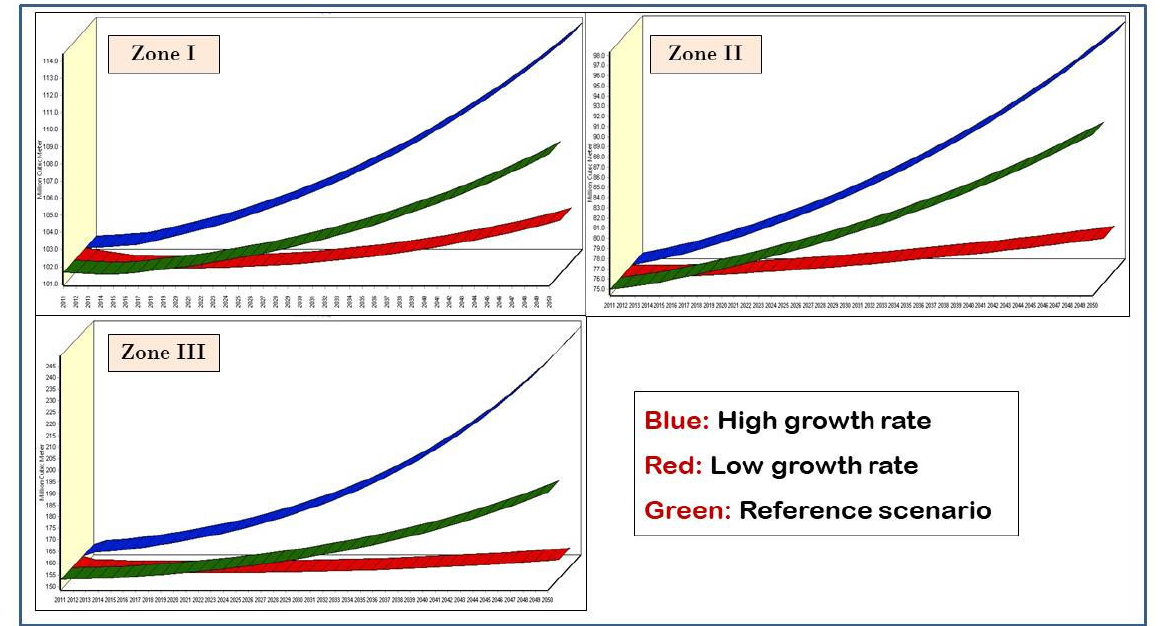
Figure 6. Total groundwater demand under different scenarios in the study area.